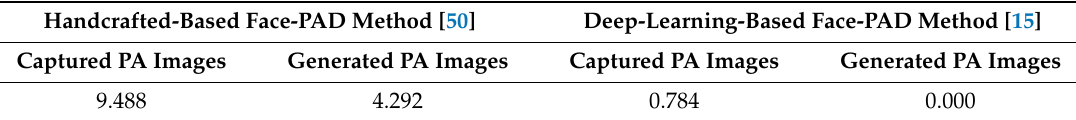
Table 9. APCERs of PA images using different face-PAD methods on CASIA dataset (unit: %). Handcrafted-based face-PAD method [ 50 ]